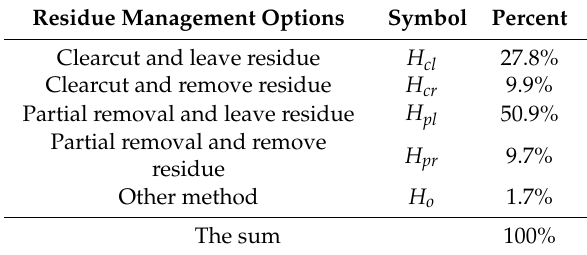
Table 1. Residue management options (%) by harvest types in Michigan (Based on study of [37]).